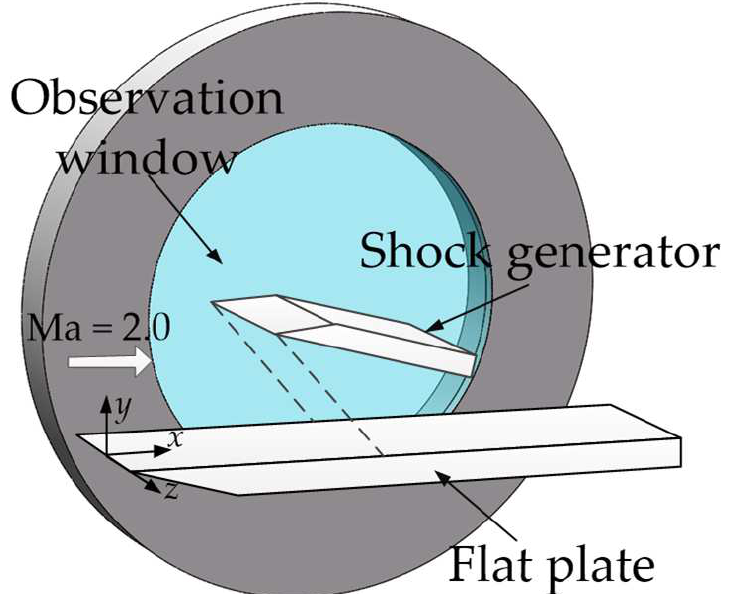
Figure 1. Schematic diagram of installation of experimental model in the wind tunnel.